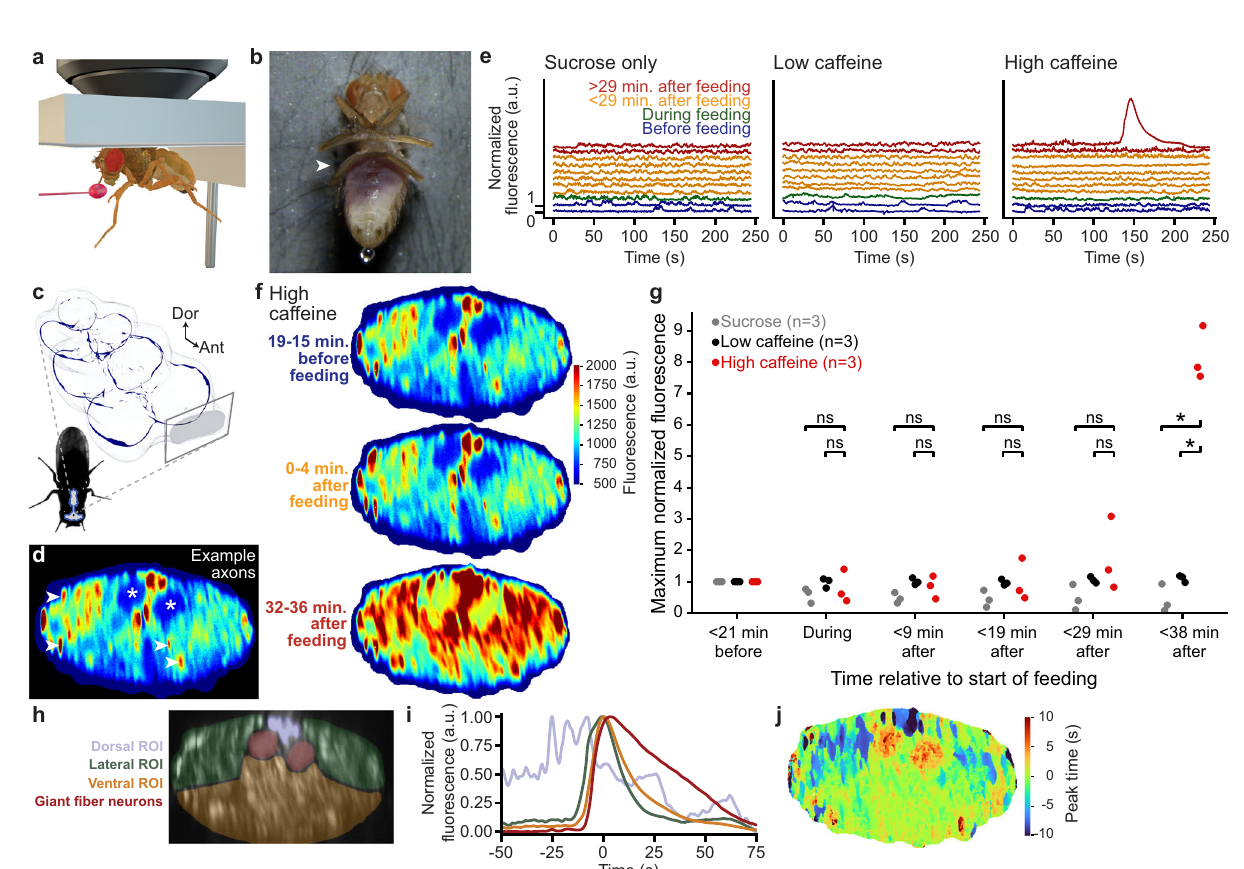
Fig.4|Continuousimagingofneuralpopulationdynamicsbefore,during,and after ingestion. a Digital rendering of a fl y being fed while neurons are recorded using a two-photon microscope. b Photo of an implanted animal after ingesting a high-concentration caffeine solution during two-photon microscopy. White arrowhead indicates purple coloration of the abdomen, con fi rming digestion of a caffeine-sucrose solution mixed with Amaranth dye. c Schematic of the ventral nerve cord indicating the imaging region in the neck connective. d Color-coded mean neural activity during all non-locomotor periods for a fl y before feeding (same data as top panel in f ) including annotations of individual axons passing throughtheneckconnective(arrowheads).Asterisksindicatelocationofgiant fi ber axons. e Normalized fl uorescence across all axons passing through the thoracic neckconnectiveduring4minrecordingseitherbefore(blue),during(green),soon after(orange), or long after (red)feeding.Flies werefedwith a